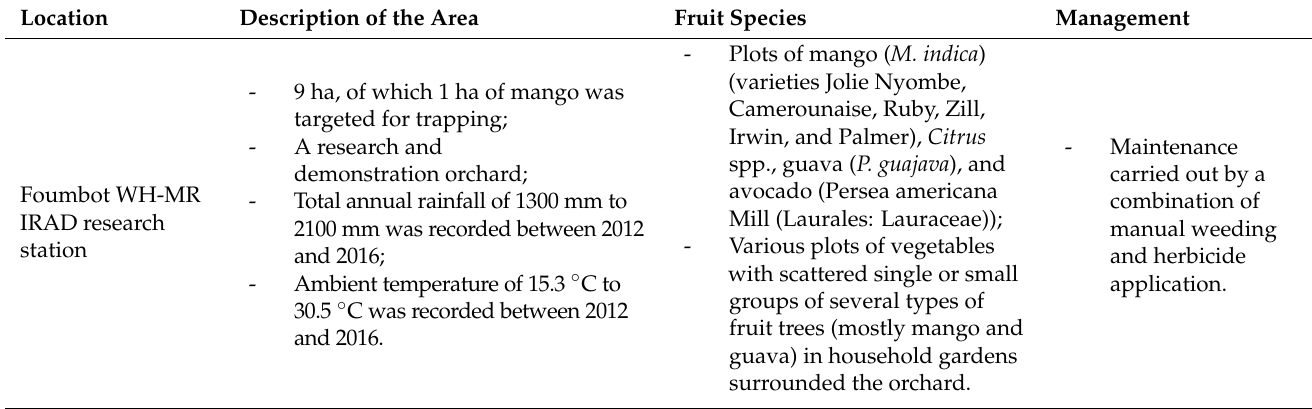
Figure 1. Fruit fly trapping and fruit sampling locations in Cameroon. Enlarged maps to the right correspond to the 2 agro-ecological zones — WH and HF-BR — targeted in this study. In addition to the two experimental sites, fruits were collected from 6 other locations in the WH-MF within a 70 km radius of Foumbot, and 5 other locations in HF-BR, within a 70 km radius of Nkolbisson (Figure 1). The selection of the fruit collection sites was based on the presence of mango or guava orchards at or in the vicinity of the collection sites. Table 1. Characteristics of the experimental sites used for fruit fly trapping in two agro-ecological zones—WH and